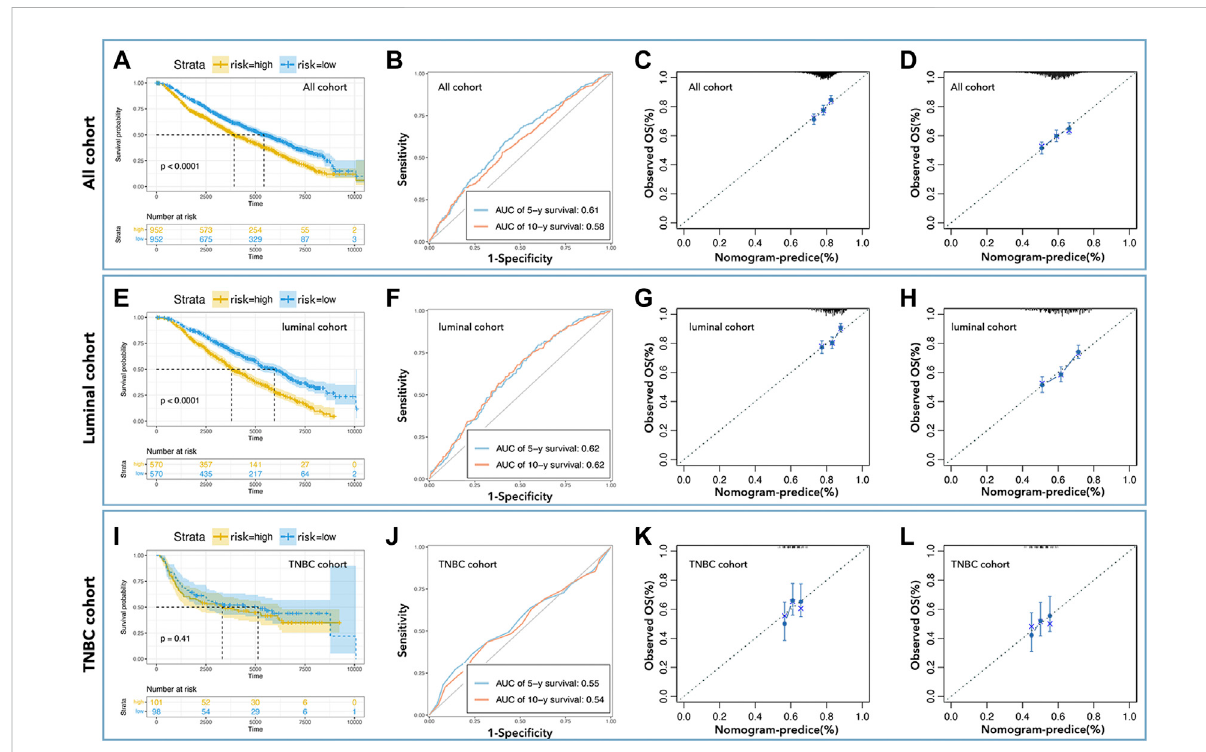
FIGURE 5 External veri fi cation of predicted models. K-M curveshowedlow-risk with better prognosis in all cohorts (A) and theluminalcohort (E) , but not intheTNBCcohort (I) .TheAUCvalues ofnomograminall cohorts (B) were0.61(5-yearsurvival)and0.58(10-year survival),intheluminalcohort (F) were 0.62 (5-year survival, 10-year survival), and in the TNBC cohort (J) were 0.55 (5-year survival) and 0.54 (10-year survival). Calibration analysis was performed to assess the prediction accuracy of nomograms in all cohorts (C,D) , the luminal cohort (G,H) , and the TNBC cohort (K,L)